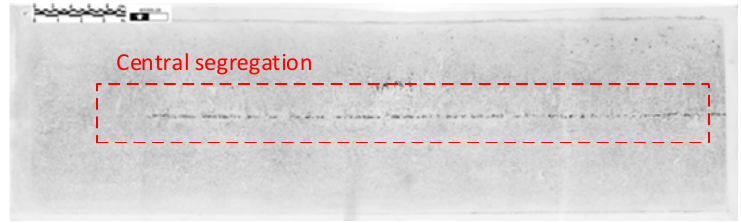
Figure 2. Example of a sulfur print.